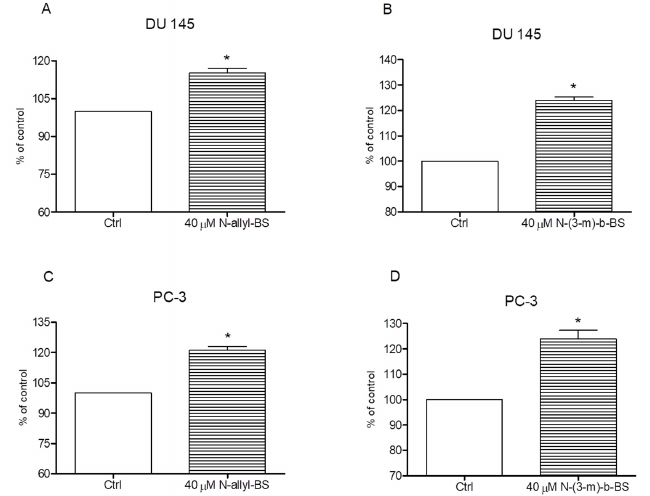
Figure 7. 40 μ M N -allyl-BS and N -(3-mb)-BS, respectively, enhance reactive oxygen species (ROS) generation in DU 145 ( A,B ) and PC-3 C,D ) cancer cells after 2h of treatment. The amount of ROS generation was assessed using flow cytometry. Results are presented as a mean ± SE of three independent experiments. The significance of differences compared to control was calculated using student T test. (*P < 0.01).